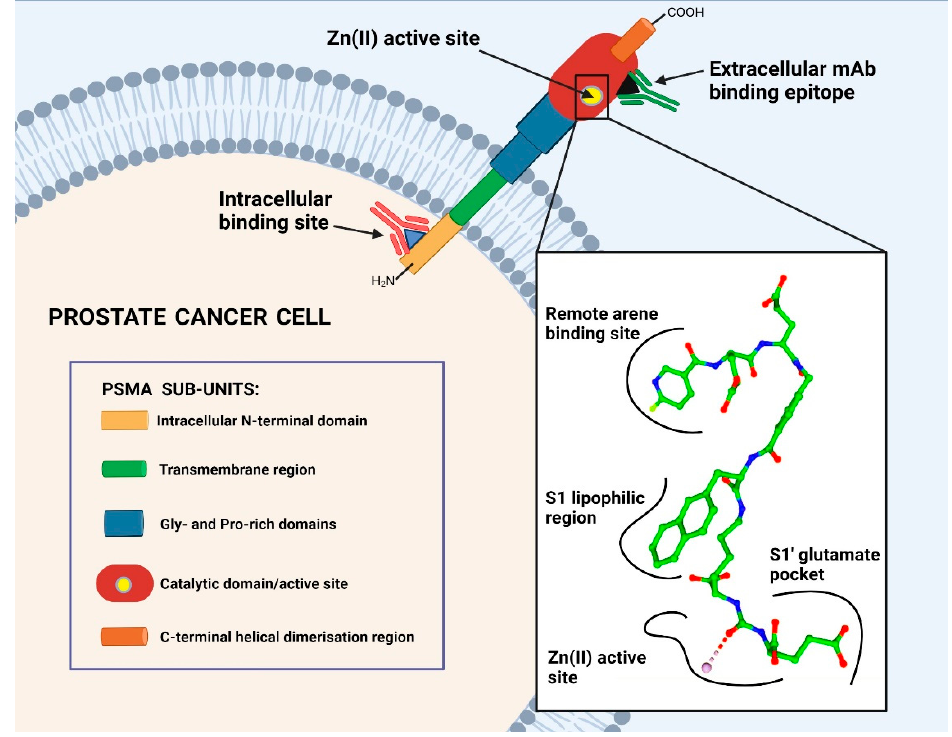
Figure 1. Schematic drawing of PSMA in the cell membrane. The various domains are represented along with the intracellular and extracellular mAb-binding epitopes. Moreover, a schematic drawing of PSMA-1007 in complex with the binding funnel is displayed with the main features present in the catalytic site of PSMA.